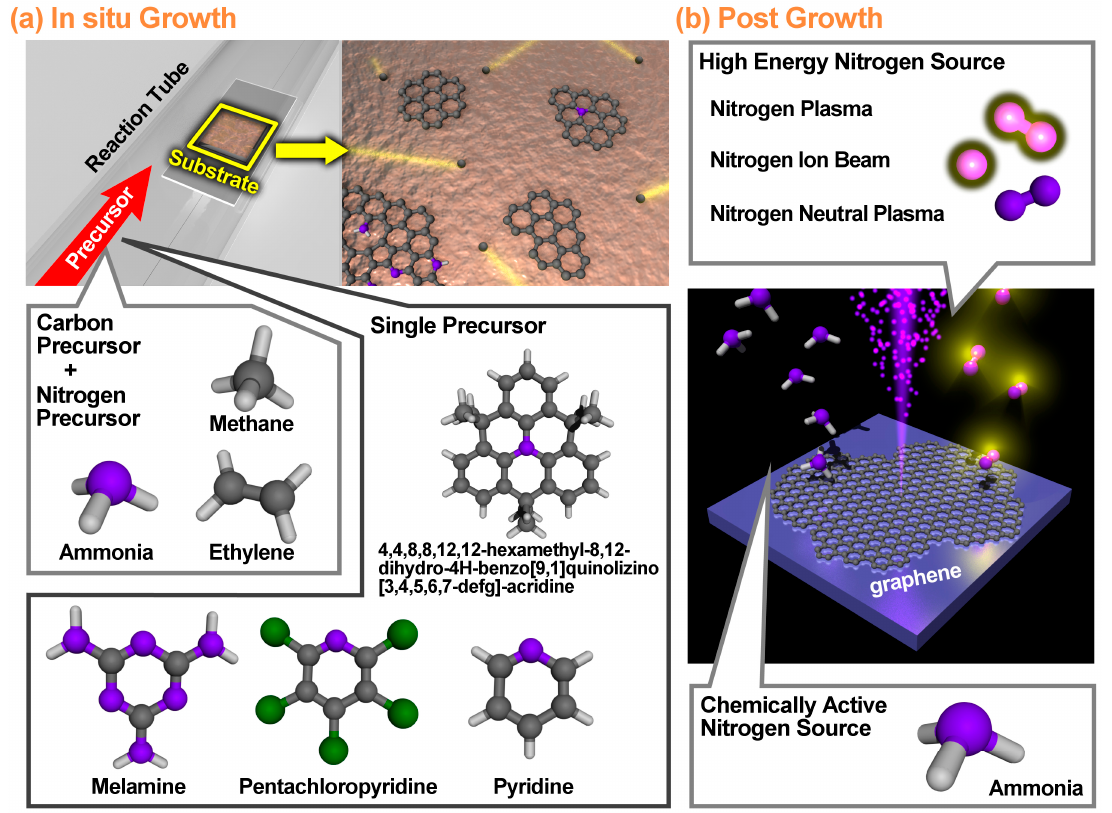
Figure 2. Schematic illustration of preparation methods of nitrogen doped graphene (NG). ( a ) in situ growth doping of nitrogen atoms via chemical vapor deposition (CVD) process. Chemicals which contain either carbon or nitrogen have been used as C- or N-precursor. ( b ) Post growth treatment to incorporate nitrogen into graphene lattice. For, post growth treatment, high energy nitrogen source and chemically active nitrogen source are used.